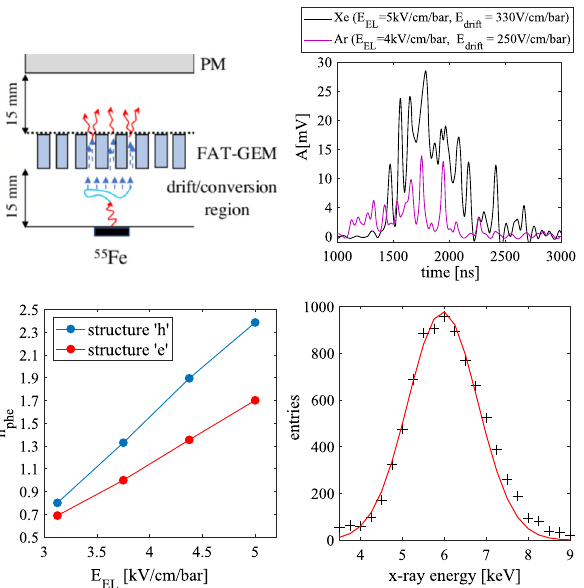
Fig. 4 (Top-left) Experimental setup used at IGFAE for the charac- terization of the WLS FAT-GEMs [25]. (Top-right) X-ray waveforms for xenon (2 bar) and argon (4 bar) after cuts. (Bottom-left) Light yield in photoelectrons per electron for xenon at 2 bar. (Bottom-right) Reconstructed energy spectrum at a reduced field in the EL region of 5 kV/cm/bar, for structure